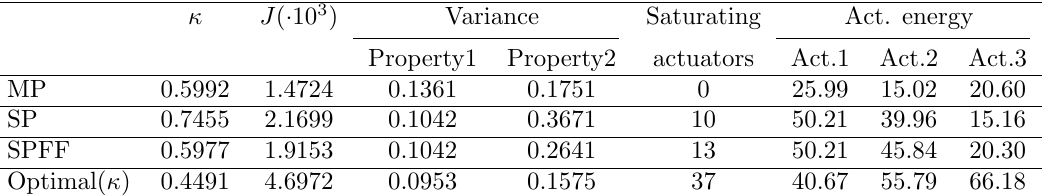
Table 3: Steady-state performance of the controllers. MP is multiple property control, SP is single property control, SPFF is single property control with full feedforward